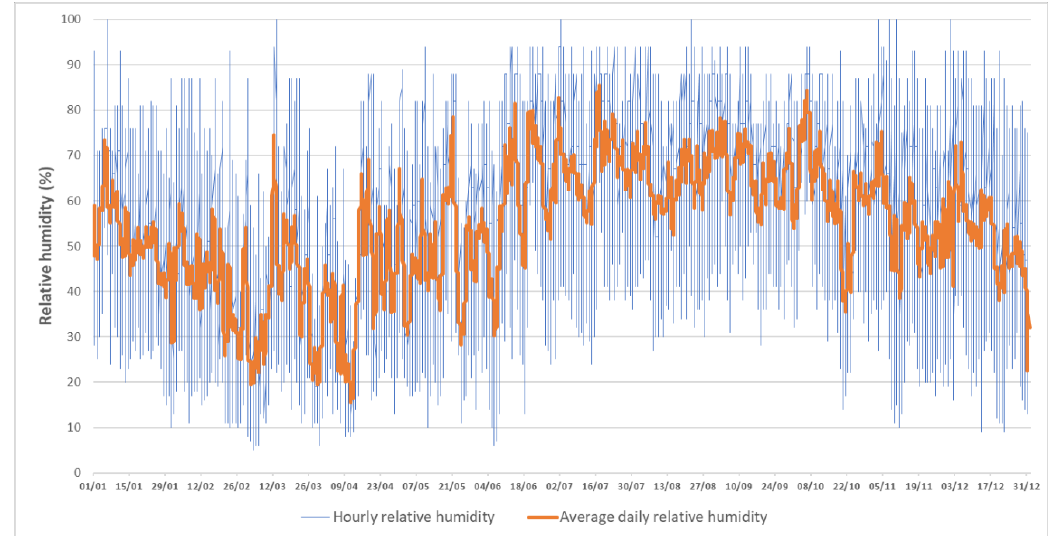
Figure 4. Hourly relative humidity and average relative humidity of the TMY of Mexico City based on its EPW files.